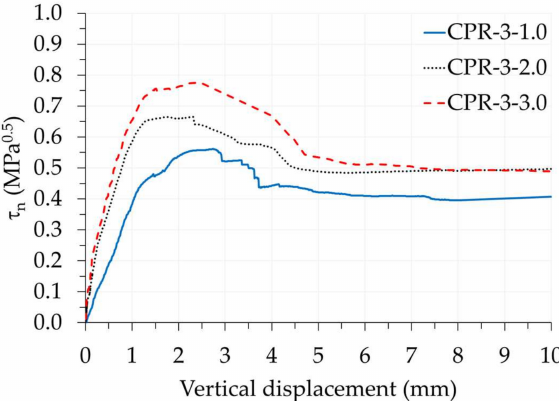
Figure 15. Normalized shear stress versus relative vertical displacement curves for the three-keyed RAC dry joint specimens.